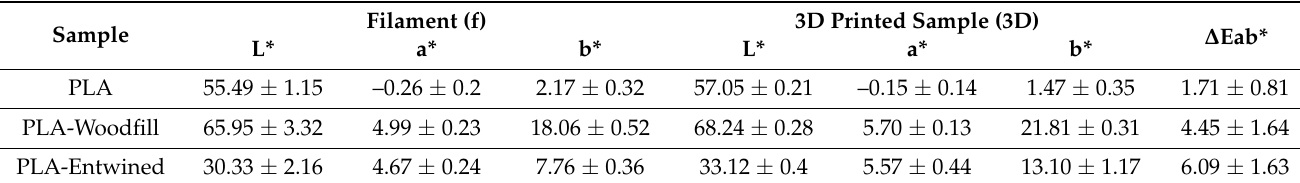
Table 1. Colour values of filaments and 3D printed samples.